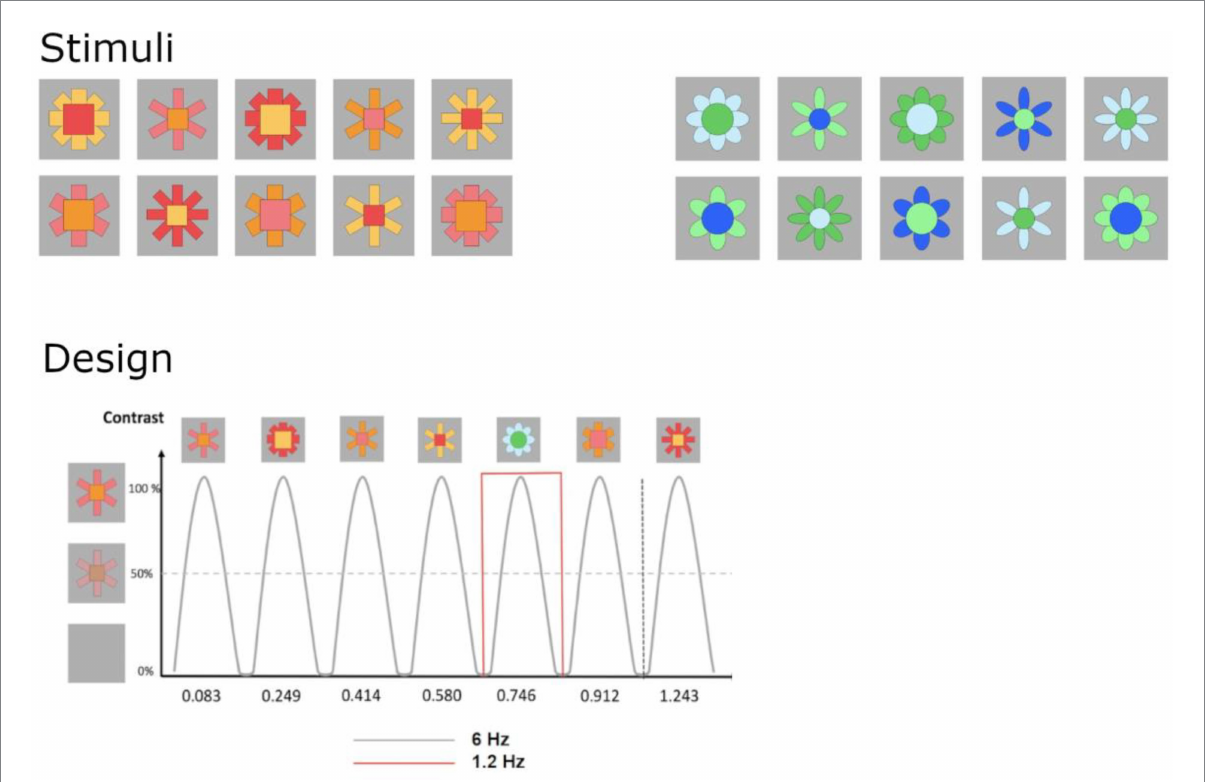
FIGURE 2 Schematic illustration of the stimuli and experimental paradigms. Ten different angular red-orange and round blue-green stimuli were employed, with contrasting categories differing in the shape of all parts (angular vs. round outlines) and colour spectrum. Phase-scrambled control images were created from original stimuli. In 20-s-sequences, images were presented by sinusoidal contrast modulation at a rate of 6 cycles per second = 6 Hz (1 cycle ≈ 170 ms). Angular red-orange stimuli (A) were presented as standards, with round blue-green stimuli presented as deviants at every 5 th cycle (B; 6/5 Hz = 1.2